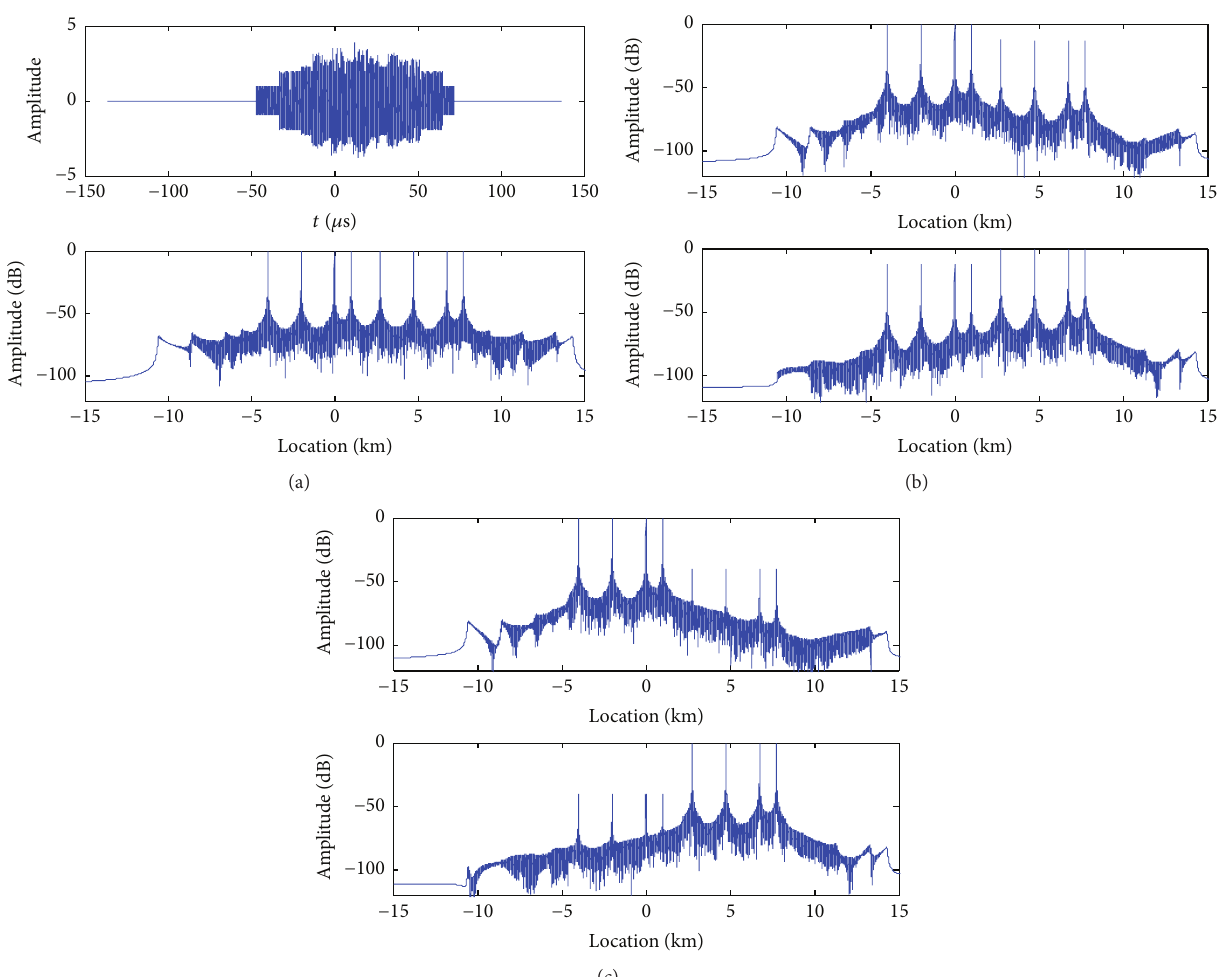
Figure 7: Echoes separation experiment. (a) Echo received by one of elevation receive channel (top) and range compressing results. (b) Echo separation results handled by the convectional DBF processor. (c) Echo separation results handled by the proposed two-step DBF